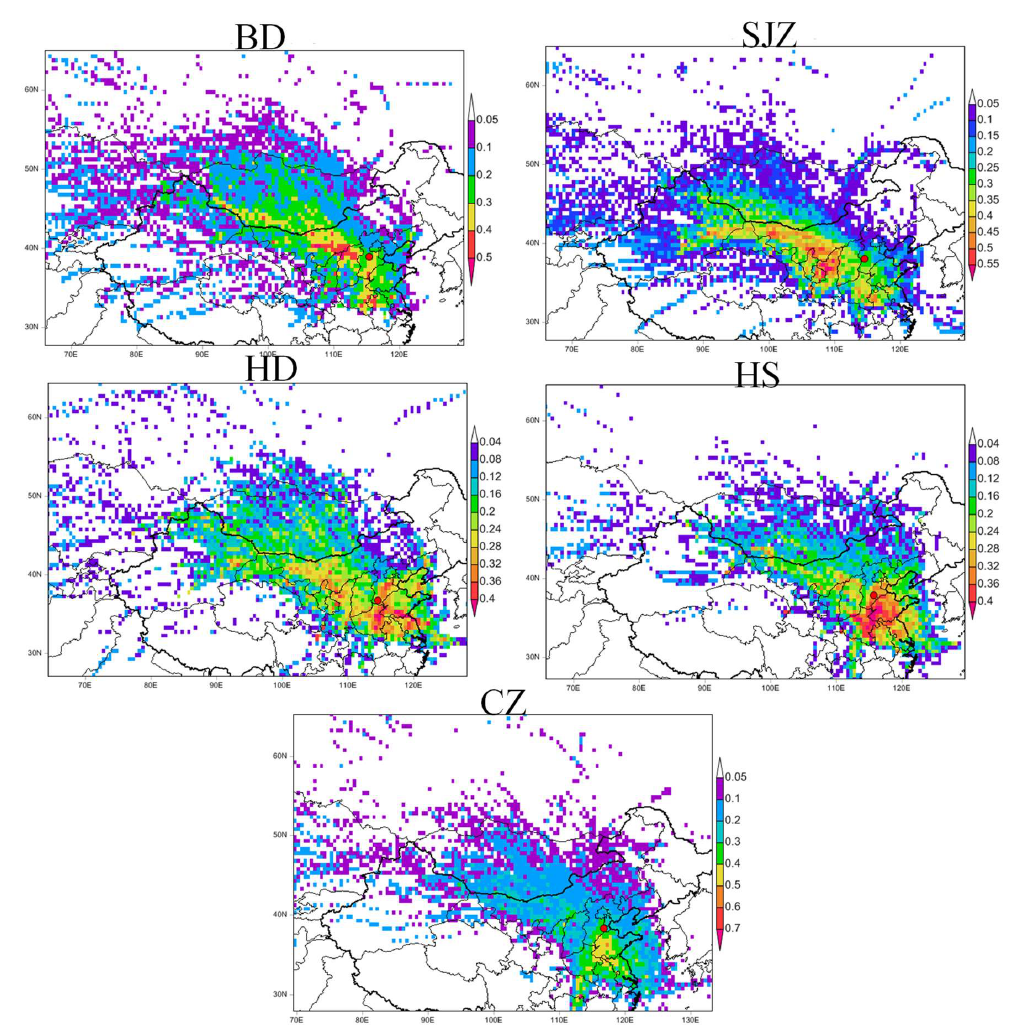
Figure 11. The Potential Source Contribution Function (PSCF) maps of the potential sources of PM 2.5 in five cities during 2013–2015. The red dot represents the target city.